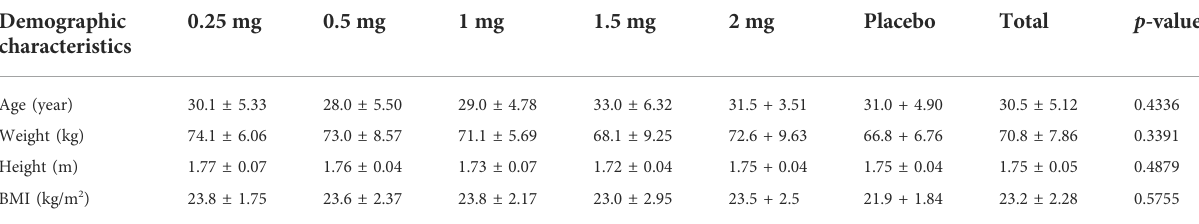
TABLE 1 Summary of demographic characteristics.